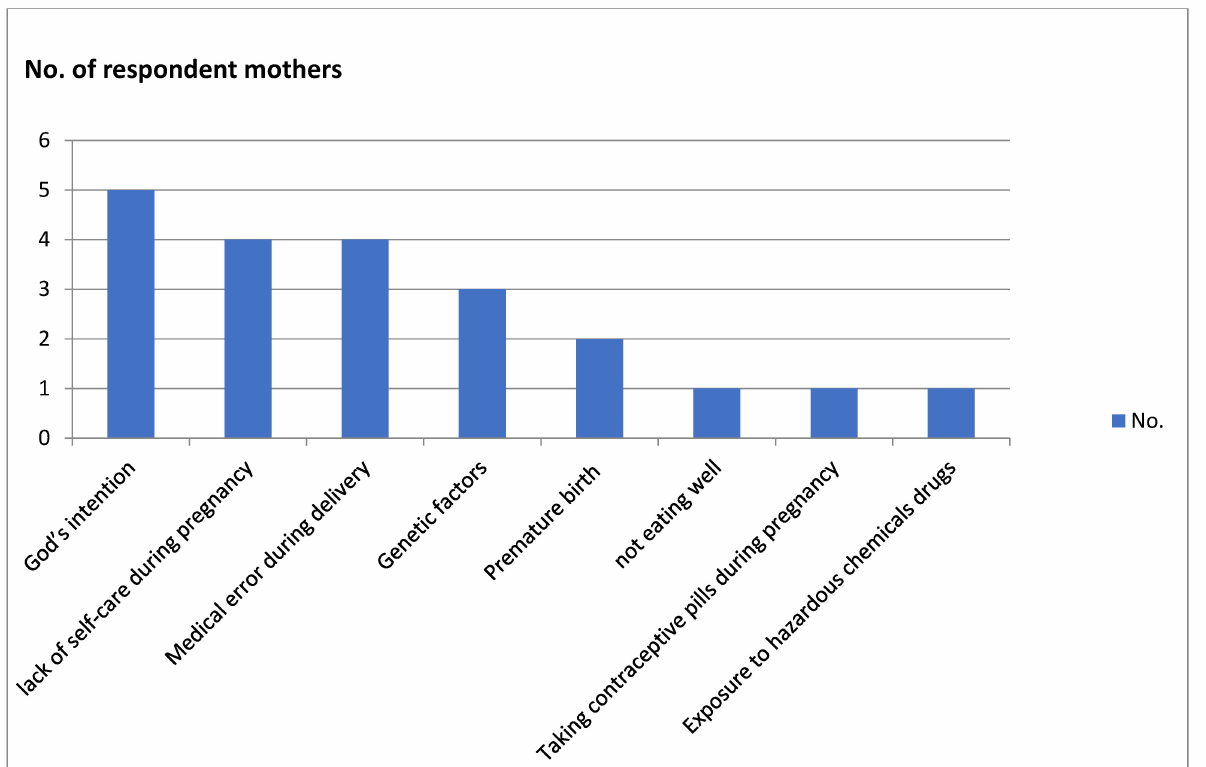
Figure 1. Mother’s causal explanations for ASD. Source: authors’ compiled interview